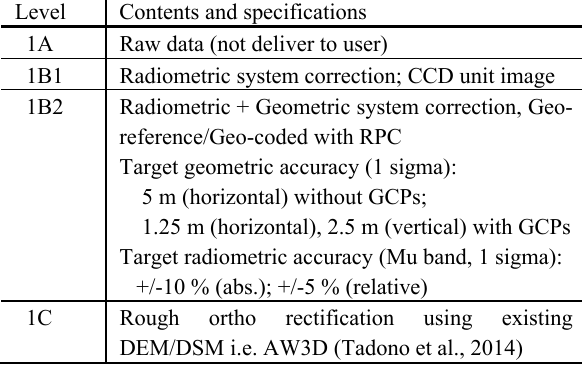
Table 3. ALOS-3 standard product and target